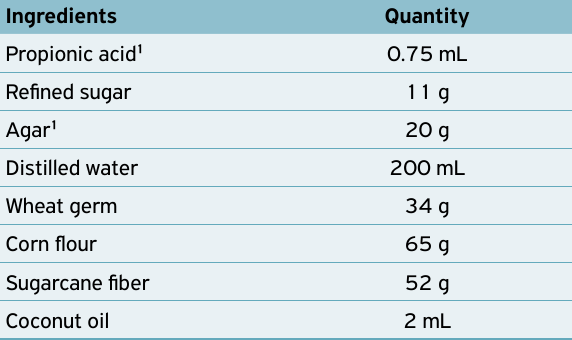
Table 1. Composition of the artificial diet used in bioassays (modified from NEGRISOLI JUNIOR et al.,